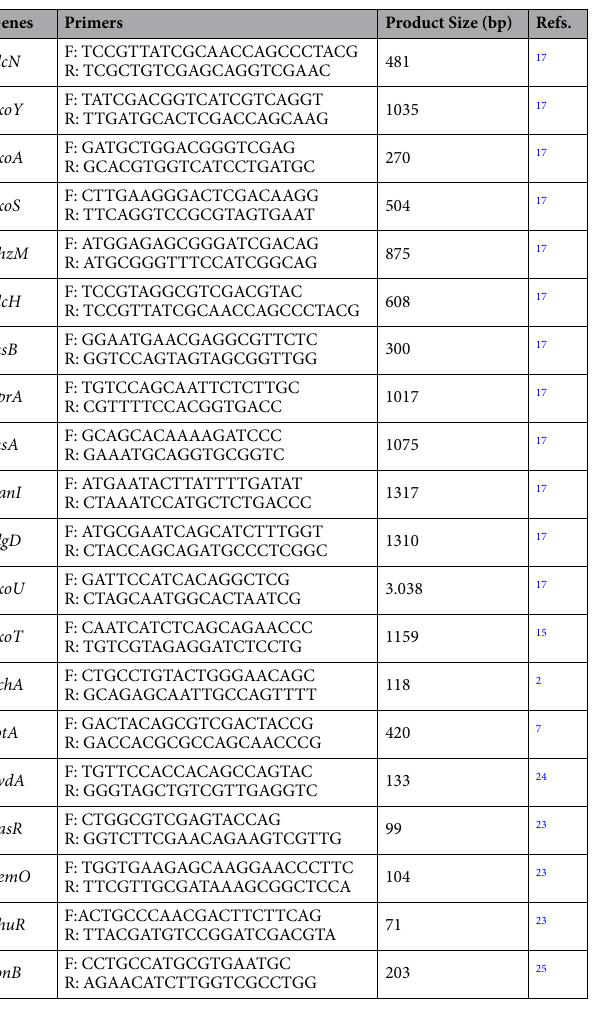
Table 2. Primers used for identification of virulence factors and siderophores, heme, and ferric citrate iron uptake genes in wound collection of P. aeruginosa. S, susceptible; R, resistant; I, intermediate. # Statistical relationship between chi-square test between different variables with significant level ≤